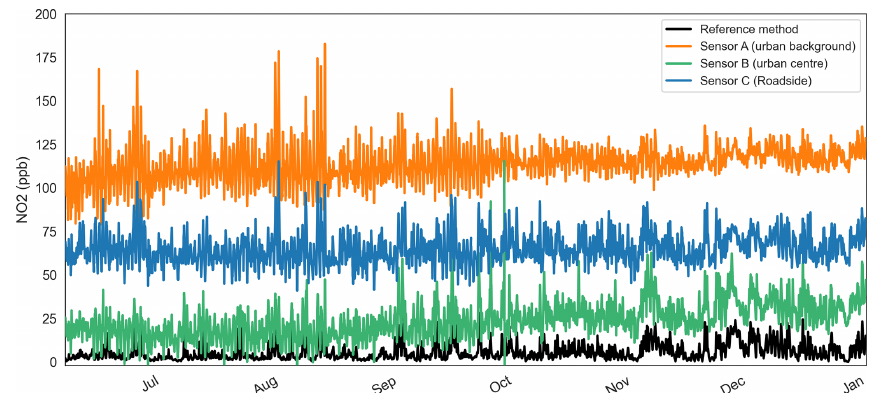
Table 2. Model feature (variables) used in RF model training and prediction by the pollutant model. T : current time. Model NO 2 PM 10 PM 2 . 5 Type Sensed concentration/mass Yes Yes Yes Stock Working electrode voltage Yes No No Stock Auxiliary electrode voltage Yes No No Stock Corrected working electrode voltage (offset corrected) Yes No No Stock Sample flow rate Sample time of flight Temperature Relative humidity (RH) Rate of change in temperature at T −